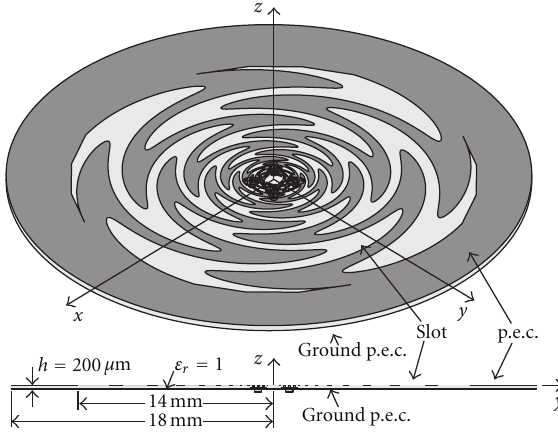
Figure 7: 3D model of the analysed slot-sinuous structure and dimensions.